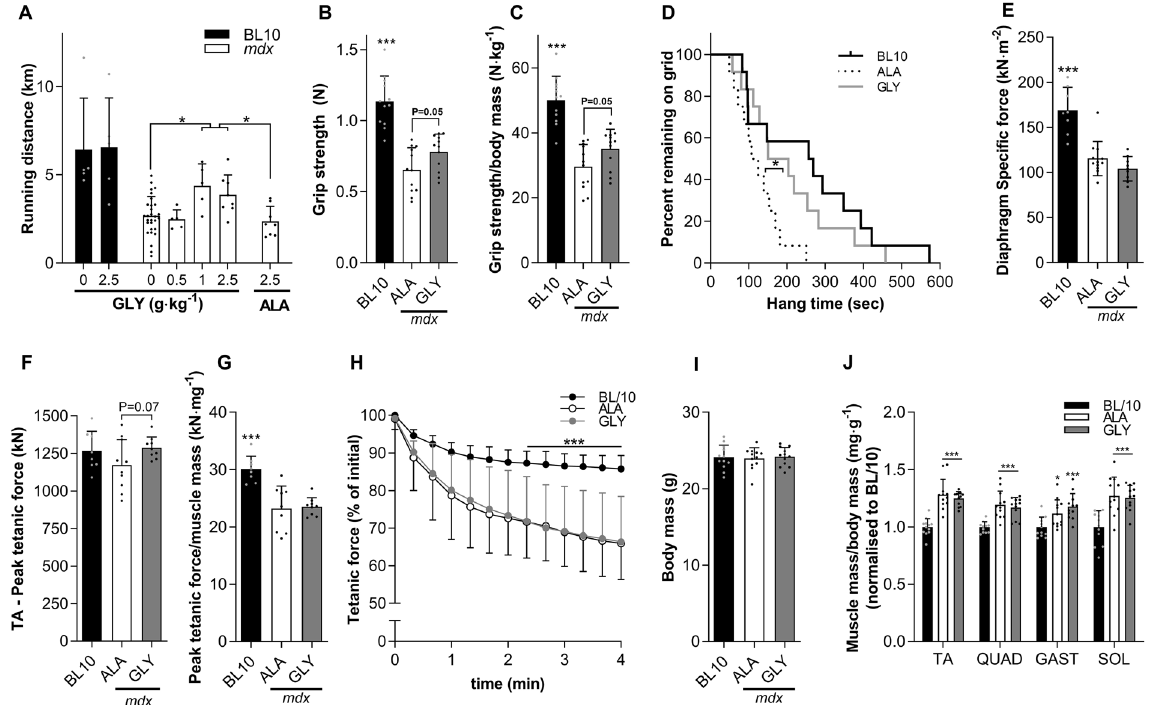
Figure 1. Glycine improves muscle function in mdx dystrophic mice. Dose-response effect of glycine feeding on running performance in mdx mice ( A ), with no effect of L-alanine (control). Three weeks of glycine feeding improved whole-body function ( B – D ), tended to improve TA peak tetanic force ( F ) but not muscle mass- normalized peak tetanic force ( G ) or diaphragm specific force ( E ), TA fatigue ( H ), body mass ( I ) or muscle mass normalized to body mass and BL/10 ( J ). The data are mean ± SD of 10–12 animals per group. Data were analyzed using one-way ANOVAs with Fishers LSD or Tukey’s (A) post hoc test, except for (D) which was analyzed using a log-rank Mantel-Cox test. * denotes p < 0.05; ** denotes p < 0.01; *** denotes p <